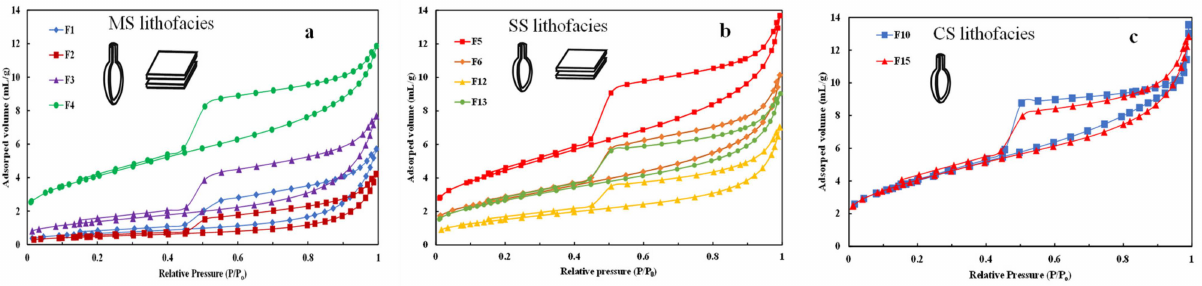
Figure 4. N 2 adsorption–desorption curve of Funing Formation shale: ( a ) MS lithofacies; ( b ) SS lithofacies; ( c ) CS lithofacies.